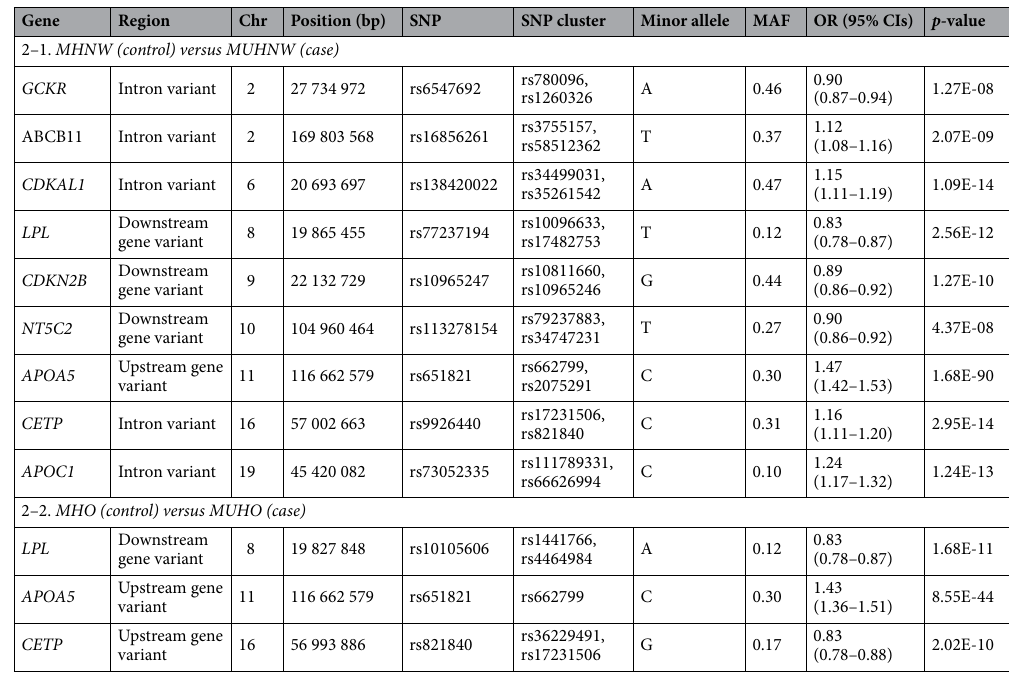
Table 2. Representative SNPs identified by GWAS among the significant loci for model 1 (MHNW versus MUHNW) and model 2 (MHO versus MUHO). Logistic regression models were adjusted for age, sex, exercise status, smoking status, alcohol intake, body mass index, and PC1 and PC2. GWAS, genome-wide association study; MHNW, metabolically healthy normal weight; MUHNW, metabolically unhealthy normal weight; MHO, metabolically healthy obese; MUHO, metabolically unhealthy obese; Chr, chromosome; SNP, single- nucleotide polymorphism; MAF, minor allele frequency; OR, odds radio; CI, confidence